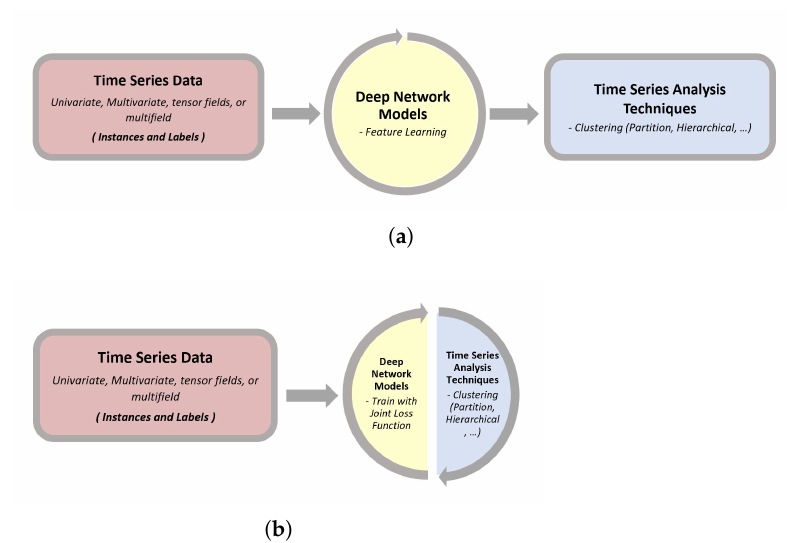
Figure 7. The pipelines of deep time-series clustering. ( a ) Multi-step deep time-series clustering; ( b ) Joint deep time-series